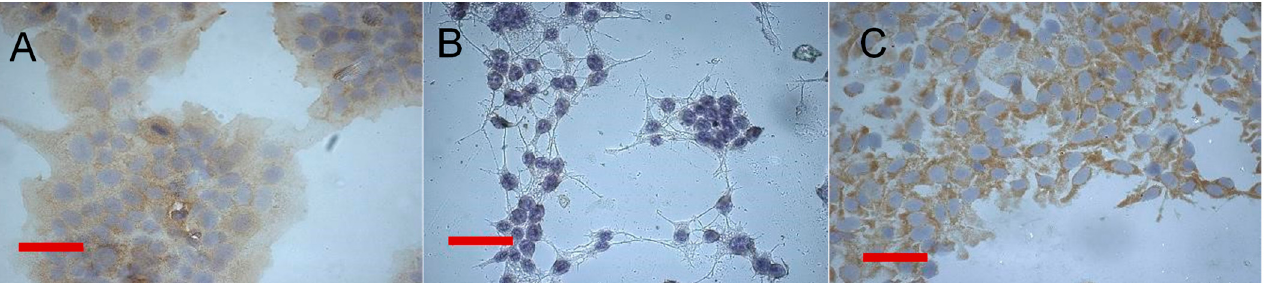
Figure 3. Immunocytochemical detection of epidermal growth factor receptor (EGFR) in fixed cells. EGFR was detected using horseradish peroxidase-conjugated anti-EGFR antibodies. DNA was stained with hematoxylin. ( A )—A431 cells, ( B )—M3 cells, ( C )—M3-EGFR cells. Scale bar represents 100 µm.